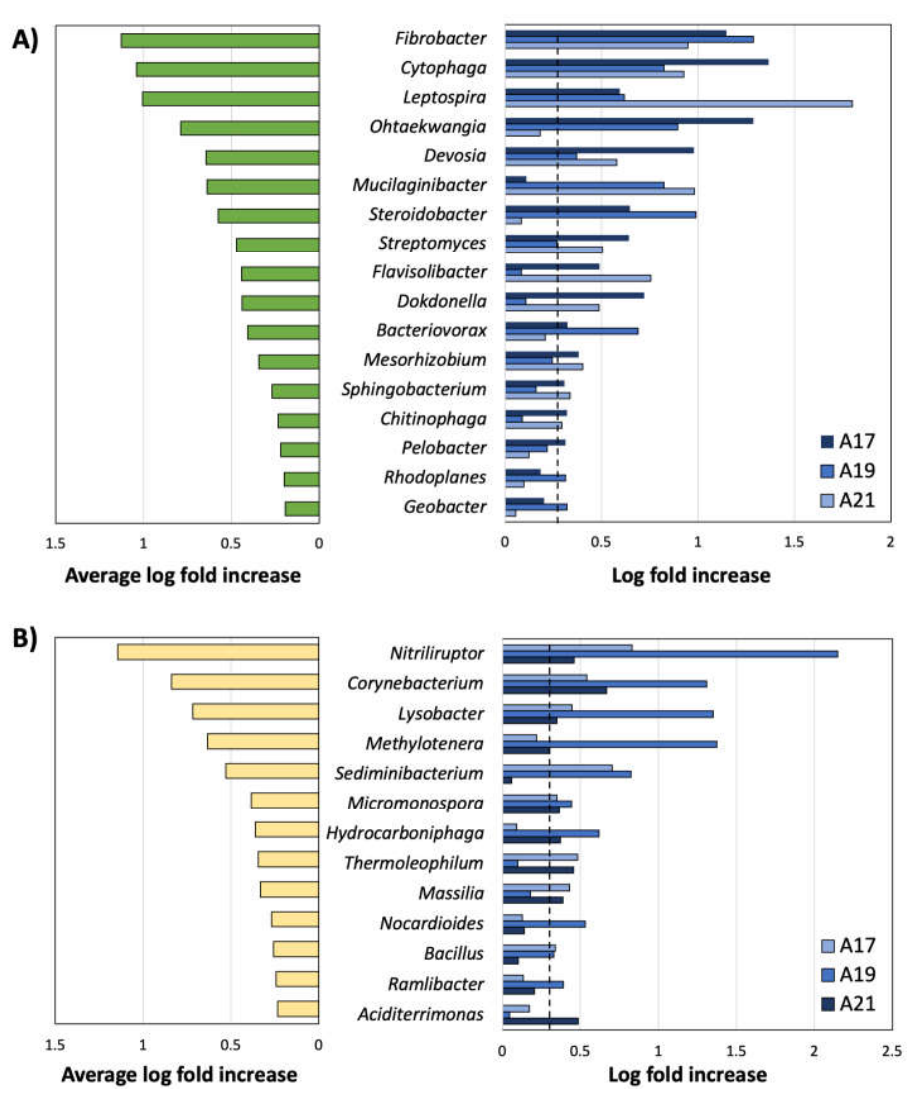
Figure 6. Genera with the largest average fold changes in native A. breviligulata stands ( A ) and barren microhabitats ( B ) when compared to each other. The left panel represents average log fold increases across all sites, while the right panel represents log fold increase for sites A17, A19, and A21. A log fold increase of 0.301 (2-fold increase) is shown in a segmented line for reference.